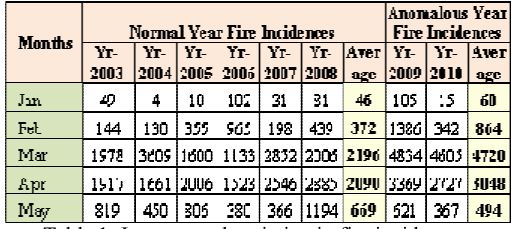
Table 1: Inter-annual variation in The graph of central India also reveals the forest fires during the peak summer season April from 2003 to 2010.